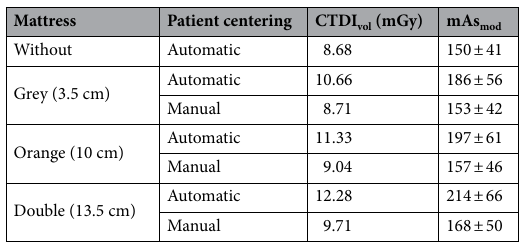
Table 2. Volume CT dose index and mean modulated mAs obtained for acquisitions of phantom with and without an additional mattress.